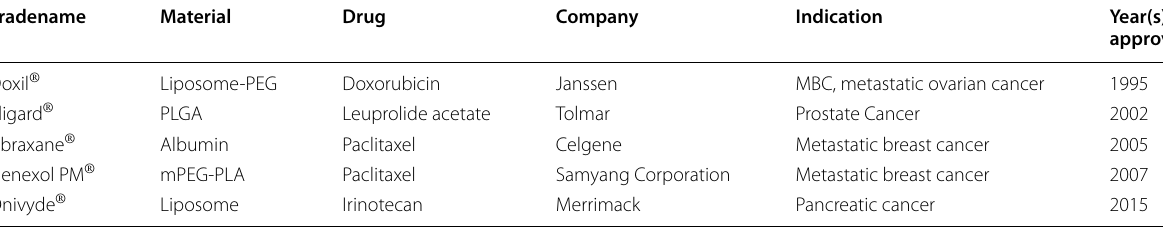
Table 1 List of nanomedicines for cancer therapy approved by FDA